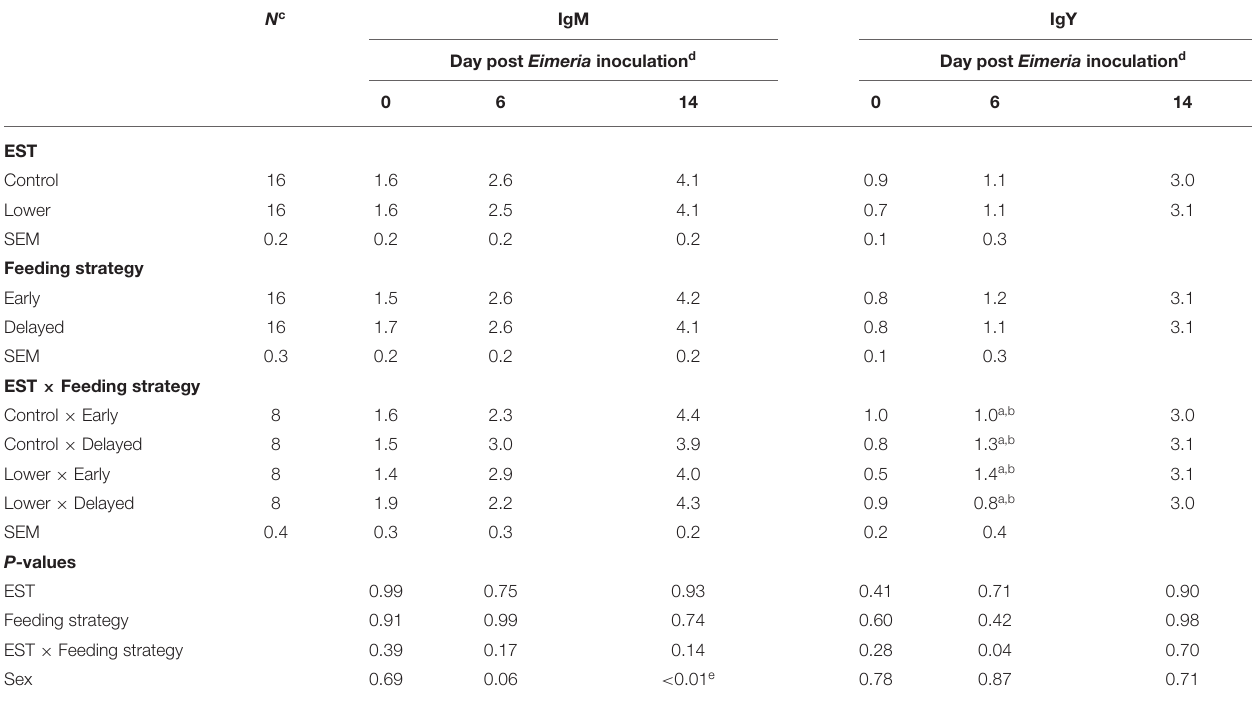
TABLE 5 | Effect of eggshell temperature ( EST ) during late incubation [ ≥ embryonic day 17–19.5; 37.8 ◦ C ( control ) or 36.7 ◦ C ( lower )] and/or feeding strategy after hatch [immediate access to feed and water ( early ) or 51–54-h deprivation ( delayed )] on IgM and IgY natural antibody (NAb) titer against keyhole limpet hemocyanin of broilers at d 0, 6, or 14 post Eimeria inoculation (d 21 post hatch) to induce necrotic enteritis (LSmeans ±